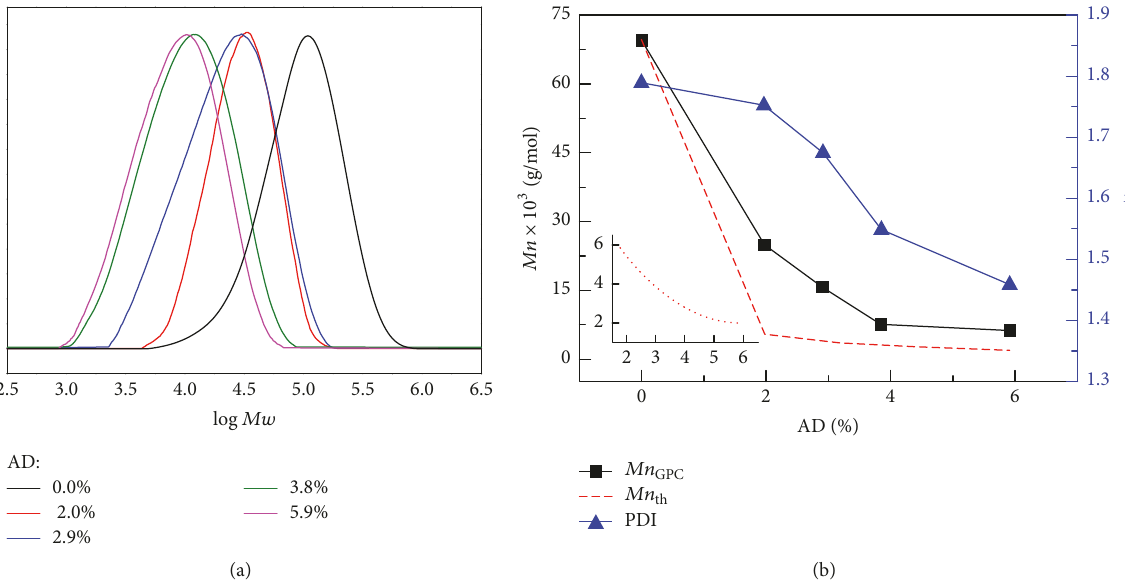
Figure 4: Evolution of GPC traces (a) and number average molecular weight (𝑀𝑛) and molecular weight polydispersity ( K = 𝑀𝑤/𝑀𝑛) (b) of the PLA-PEA with aminolysis degree (𝐴𝐷)